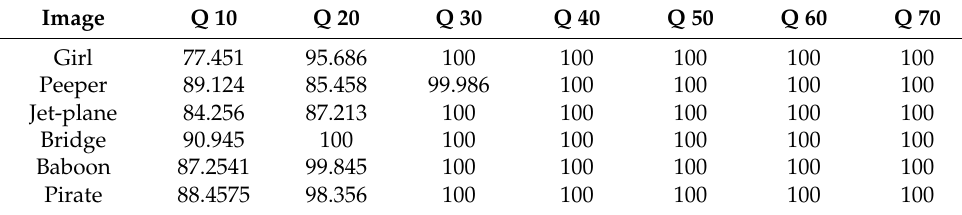
Table 4. Robustness against JPEG compression attacks in terms of BCR (%).